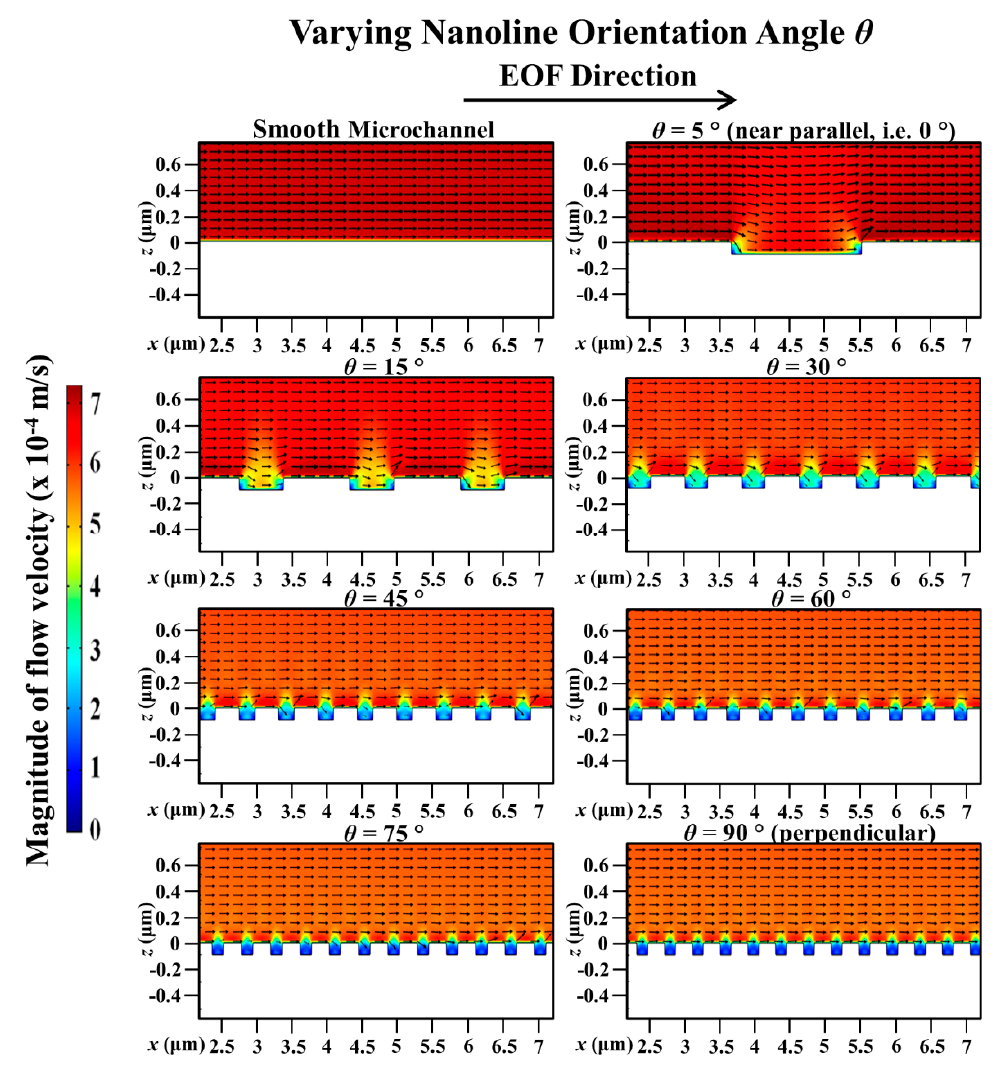
Figure 4. Simulated electroosmotic flow (EOF) velocity profile in microchannel with varying nanoline orientation angle θ , in comparison to smooth microchannel. Sodium bicarbonate (NaHCO 3 ) concentration was fixed at 1.0 mM, and nanoline width W , period P , and depth D were fixed at 160 nm, 400 nm, and 90 nm, respectively. When θ = 5°, EOF profile is not significantly affected due to less electric field distortion. As θ increases, the profile is more asymmetric as the average electric field along the nanostructured wall decreases.